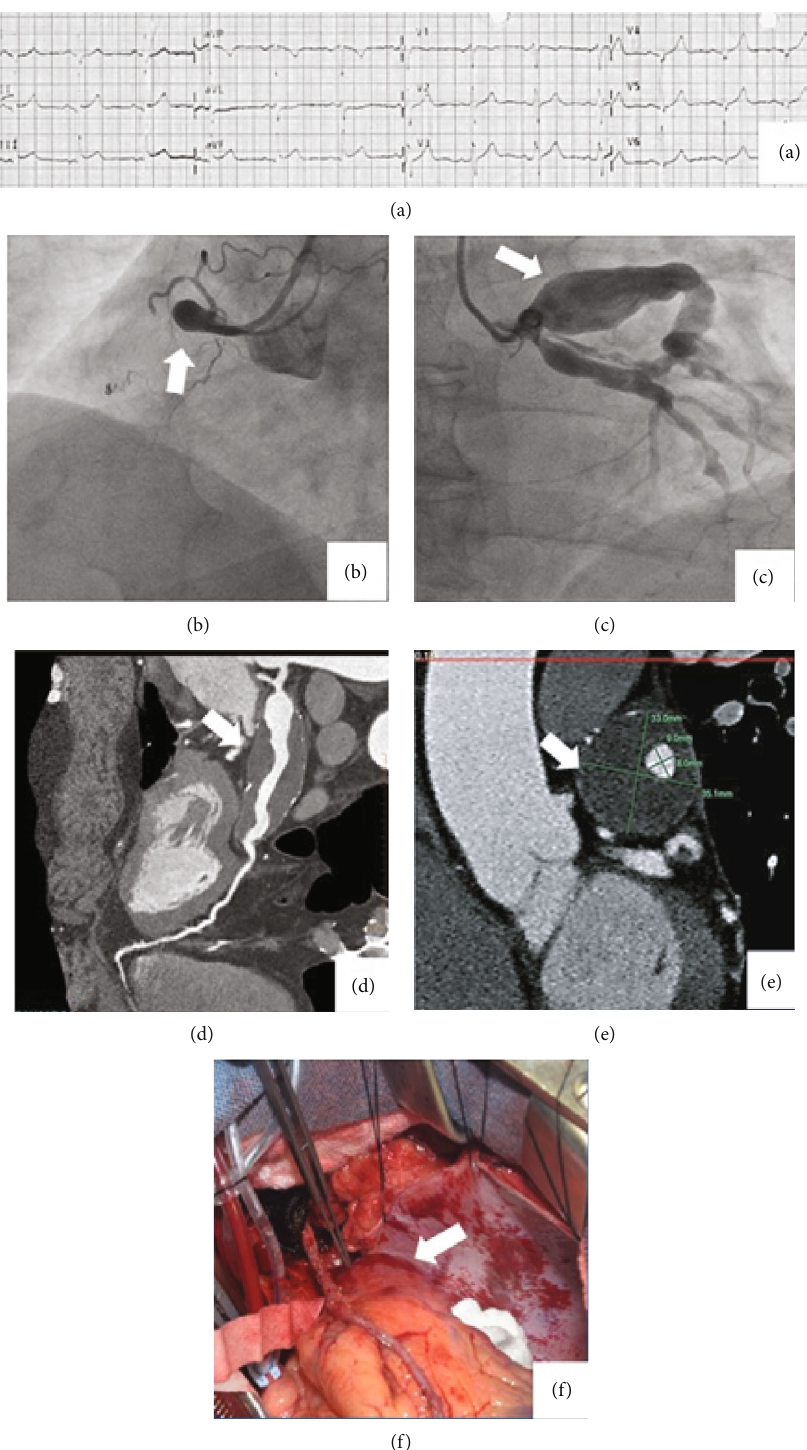
Figure 1: (a) Twelve-lead ECG on admission. ST segment elevation in leads II, III, and AVF is evident. Acute ST elevation inferior wall infarction was con fi rmed by troponin T dynamics over the following week. (b) Coronary angiography showing a large coronary aneurysm involving the proximal right coronary artery (white arrow) with complete occlusion of the artery. (c) Coronary angiography showing large coronary aneurysms involving the left anterior descending (black arrow) and circum fl ex (white arrow) coronary arteries. (d) CT angiography showing the gigantic proximal left anterior descending coronary artery aneurysm (white arrow). (e) Actual measurements of the left anterior descending coronary artery (LAD) aneurysm (white arrow): the maximal outer size of the LAD aneurysm is 35 × 33 mm , and the size of the lumen of the LAD is 9 × 11mm . (f) A view from the operation showing the large aneurysm involving the left anterior descending artery (forceps tip and white